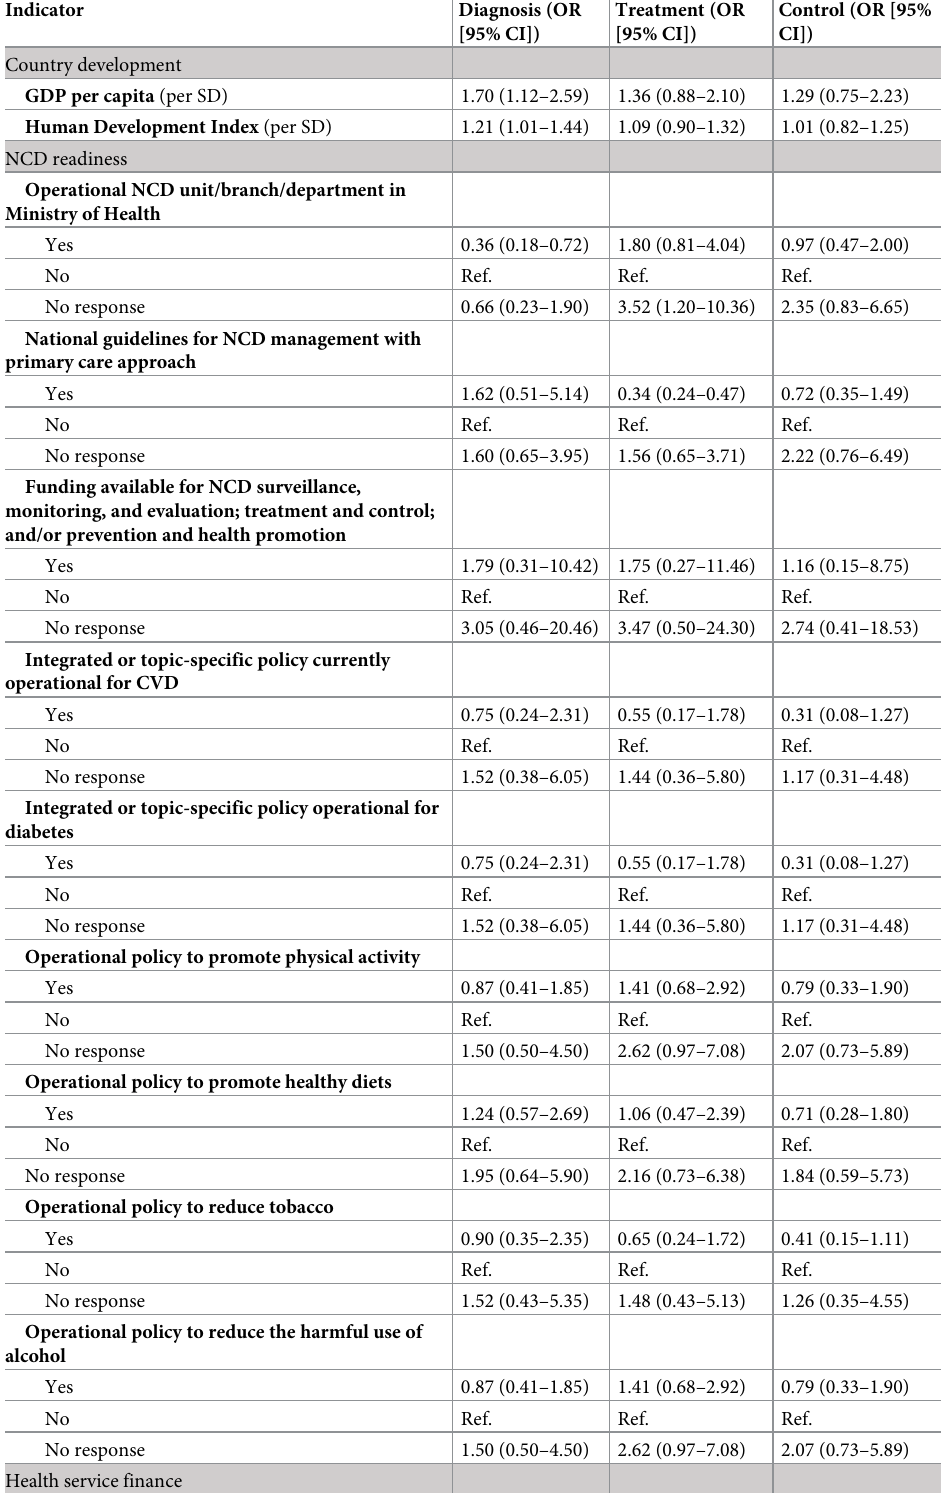
Table 6. Association between indicators and care for diabetes among individuals with